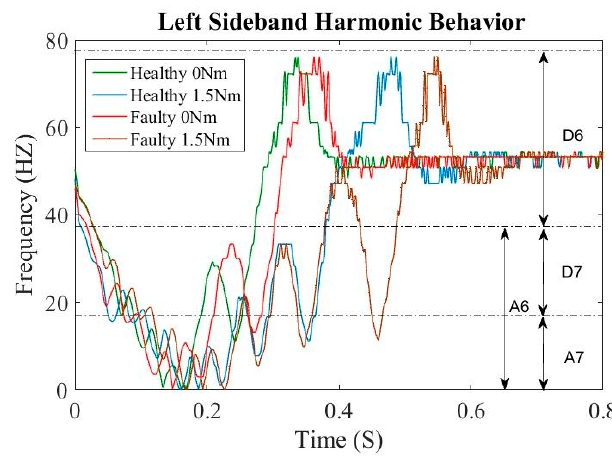
Figure 16. The behavior of LSH from experimental data.